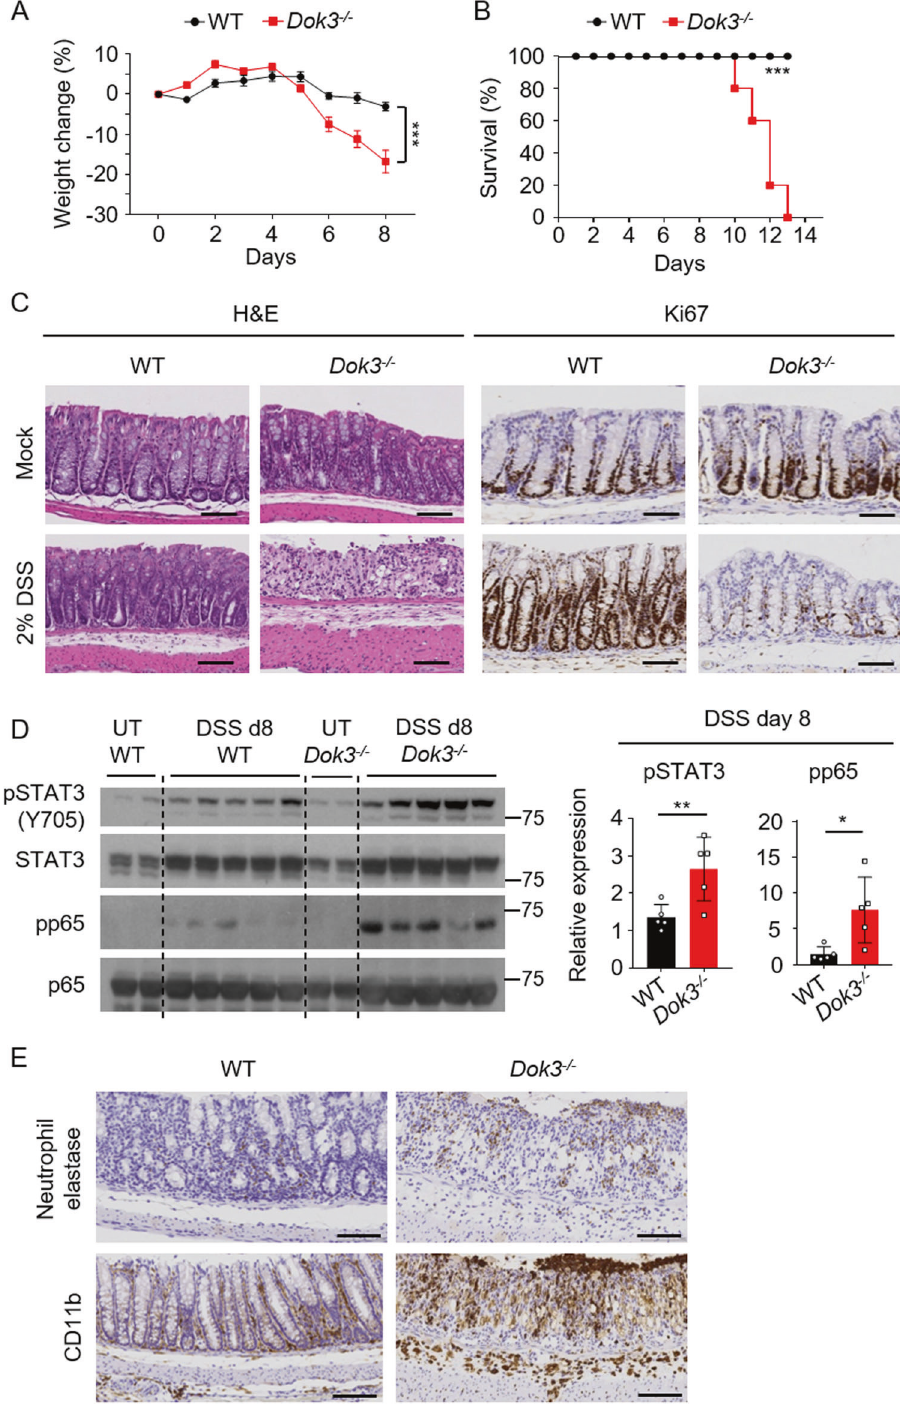
Fig. 1 Loss of DOK3 enhances susceptibility to DSS-induced colitis. WT and Dok3 − / − mice were given 2% DSS in their drinking water for 7 days. A Body weight and B survival were scored daily. A Data is shown as mean±S.E.M ( n = 5). *** p < 0.0001, two-way repeated-measures ANOVA. B *** p = 0.0002, log-rank test. C Colon tissues were collected on day 8 and stained with H&E or Ki67. Scale bars, 100 µm. D Immunoblot analysis (left) and densitometry (right) of phosphorylated and total STAT3 and NF- κ B p65 in the colons of untreated (UT) or DSS-treated mice (day 8). Each lane in the immunoblot represents one sample examined. Data is shown as mean ± SD ( n = 5). * p = 0.02, ** p = 0.01, unpaired two-tailed Student ’ s t -test. E Colon tissues were collected on day 8 and stained with neutrophil elastase or CD11b. Scale bars, 100